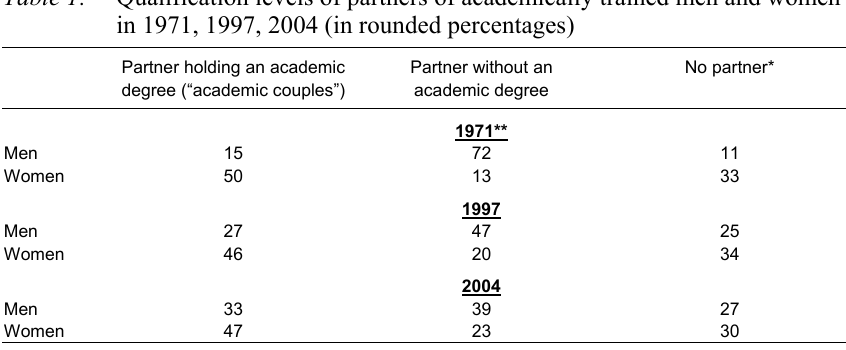
Table 1: Qualification levels of partners of academically trained men and women in 1971, 1997, 2004 (in rounded percentages) Partner holding an academic Partner without an No degree (“academic couples”) academic degree